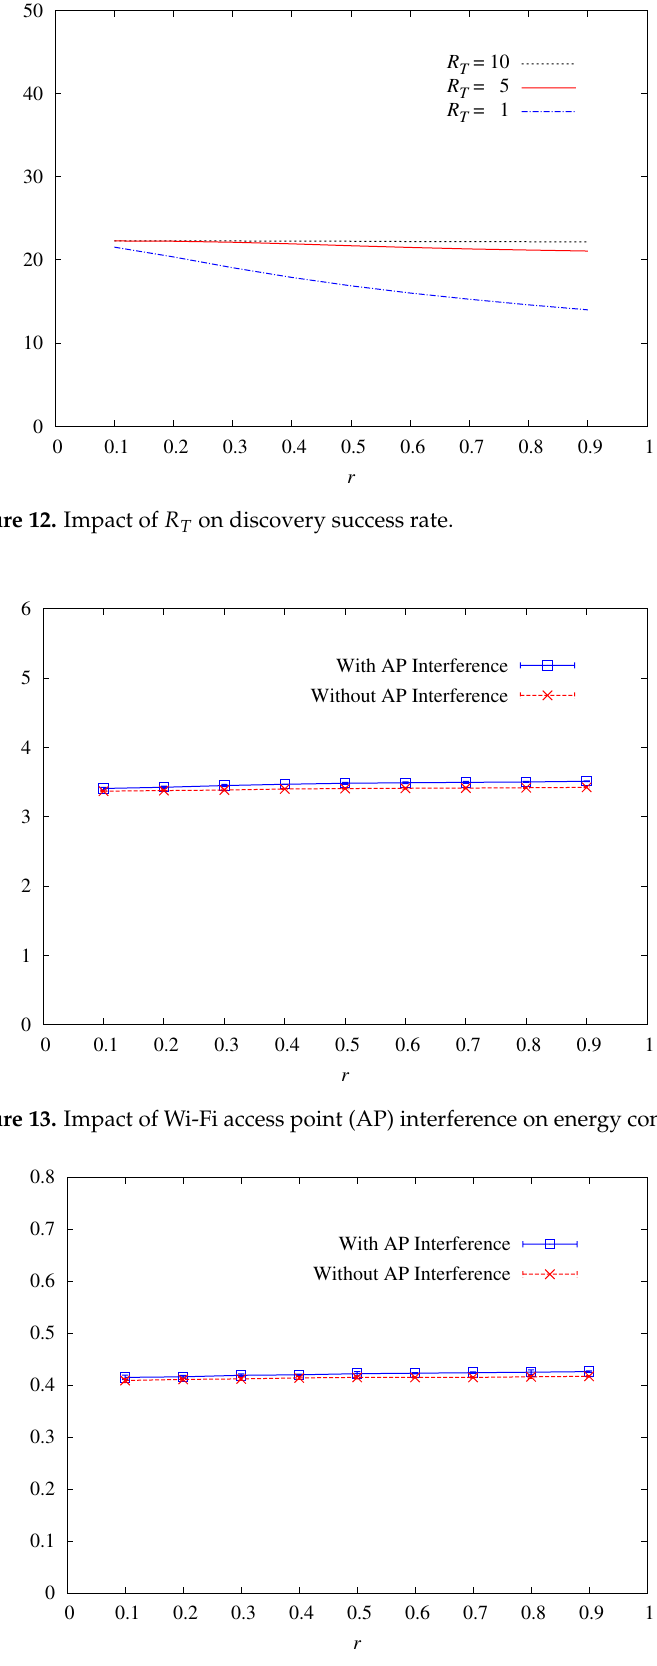
Figure 14. Impact of Wi-Fi AP interference on discovery